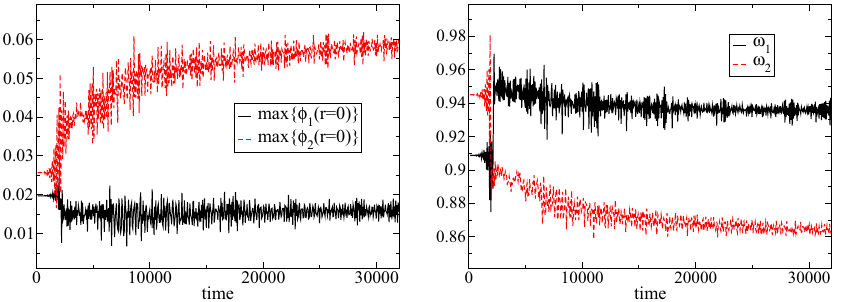
Fig. 9 Left: The maximum of the central value of each of the two scalar fields constituting the multi-state BS for the fraction η = 3, where η ≡ N ( 2 ) / N ( 1 ) defines the relative “amount” of each state. Right: The frequencies associated with each of the two states of the multi-state BS. At t = 2000, there is a flip in which the excited state (black solid) decays and the scalar field in the ground state (red dashed) becomes excited. Discussed in Sect. 3.7. Reprinted with permission from Bernal et al. (2010); copyright by